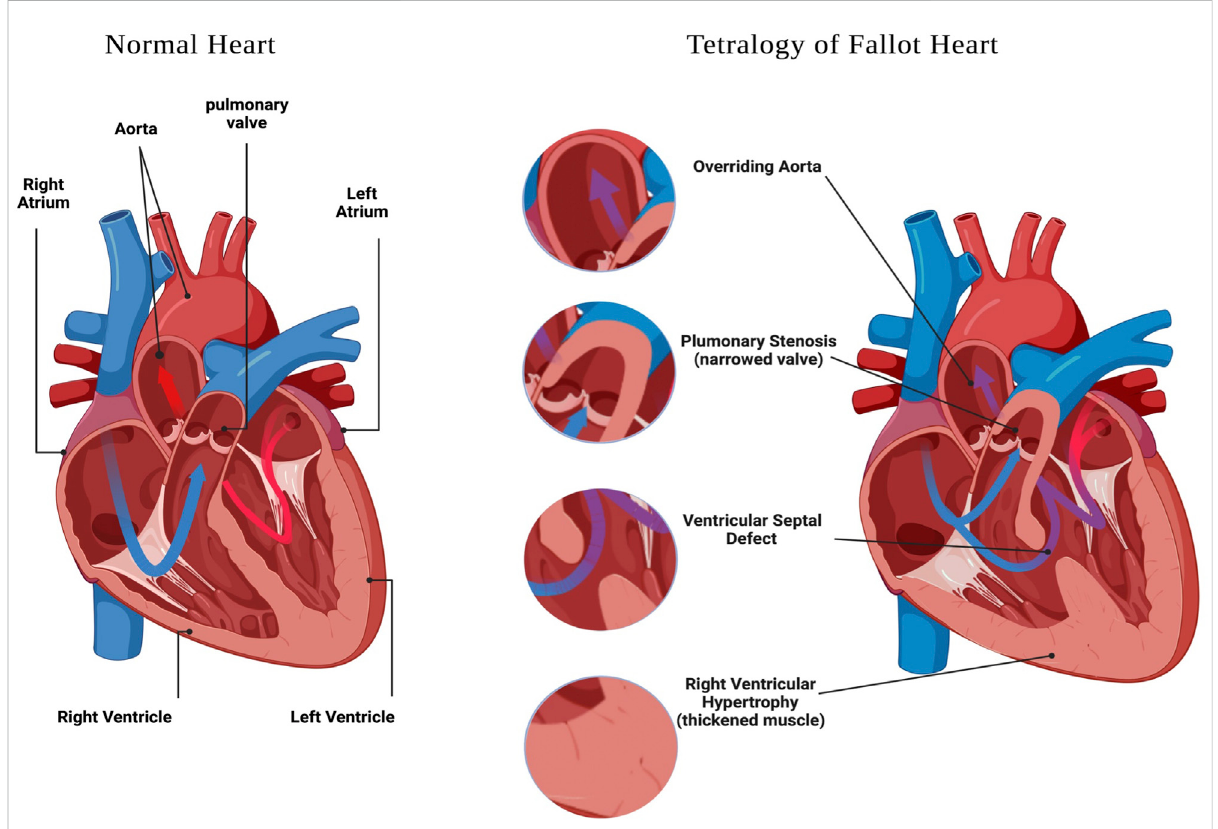
FIGURE 1 Tetralogy of Fallot features. A schematic representation of a heart with: Ventricular Septal Defect, Overriding Aorta, Pulmonary Stenosis and Right Ventricular Hypertrophy. Created with